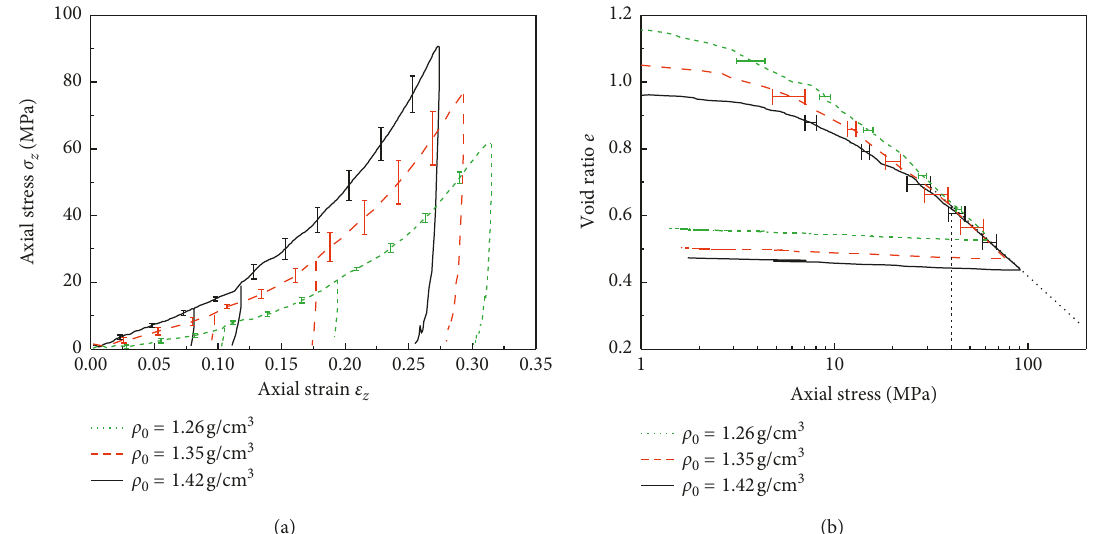
Figure 8: Effect of initial density on the dynamic axial response of calcareous sand. (a) The axial strain-stress curves of calcareous sand. (b) The e -log σ curves of calcareous sand.